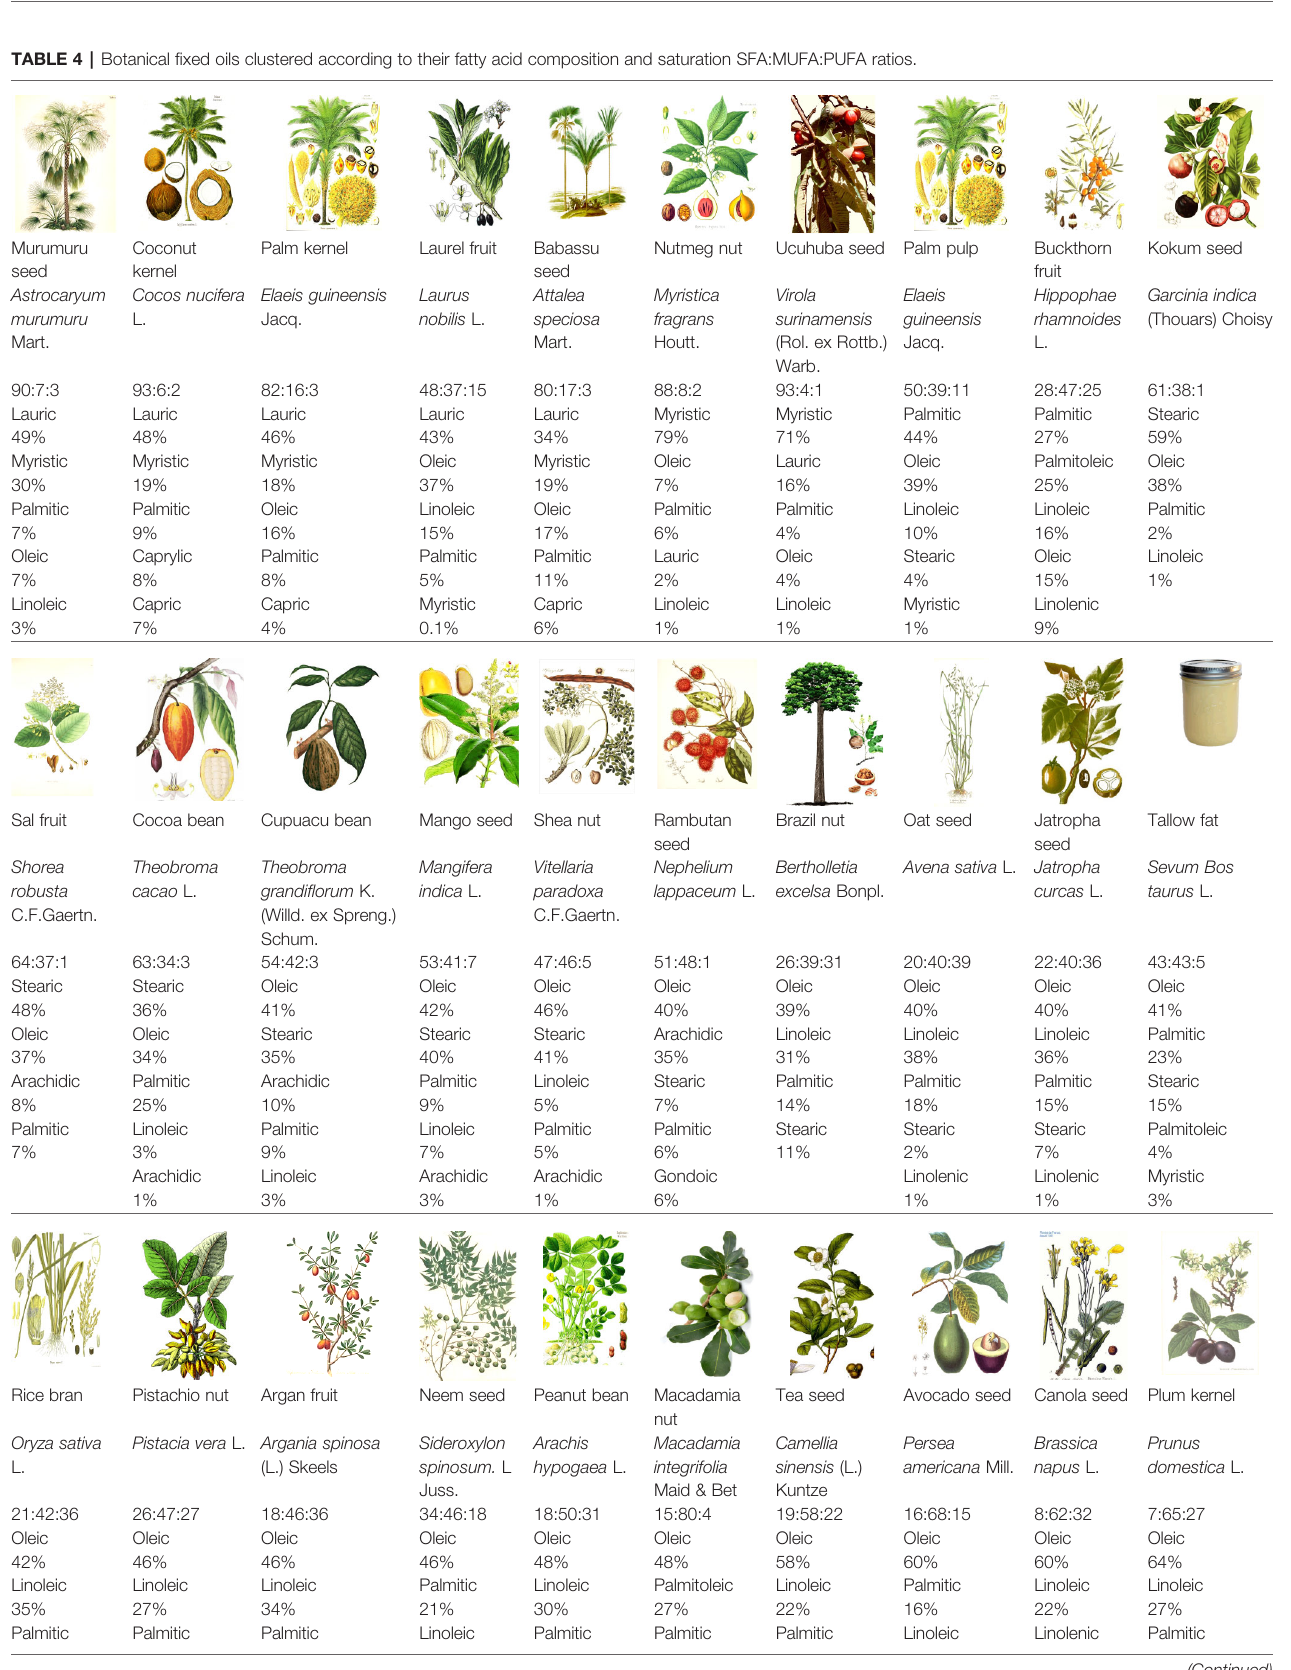
TABLE 4 | Botanical fi xed oils clustered according to their fatty acid composition and saturation SFA:MUFA:PUFA ratios.